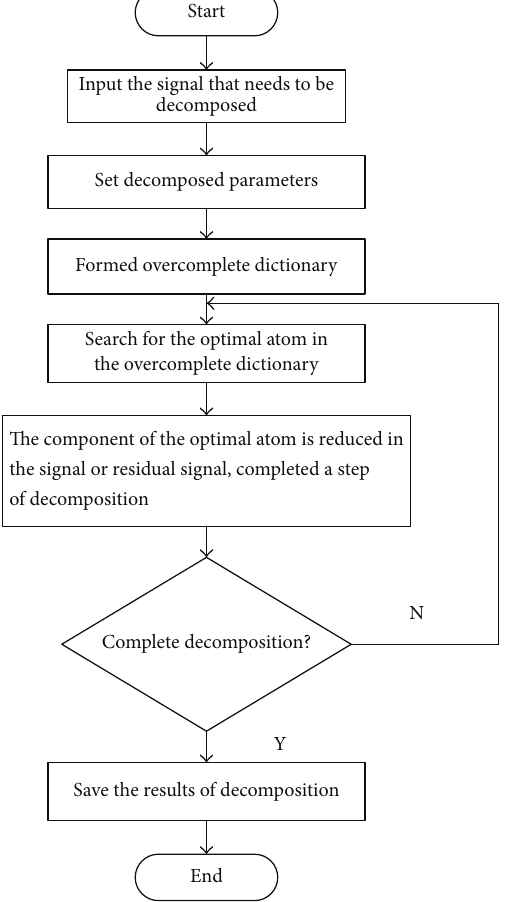
Figure 2: The flow chart of sparse representation based on MP